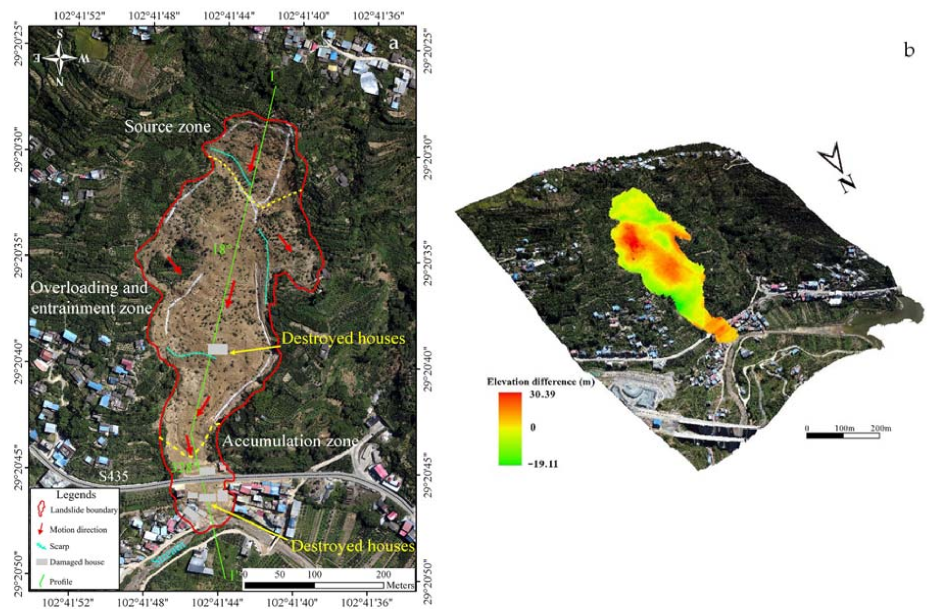
Figure 2. ( a ) Orthophotos showing the landslide boundary, source zone, overloading and entrainment zone, and accumulation zone. Orthophotos are made from UAV images using the ContextCapture software with a 0.08-m resolution. ( b ) Pre- and post-landslide elevation difference.